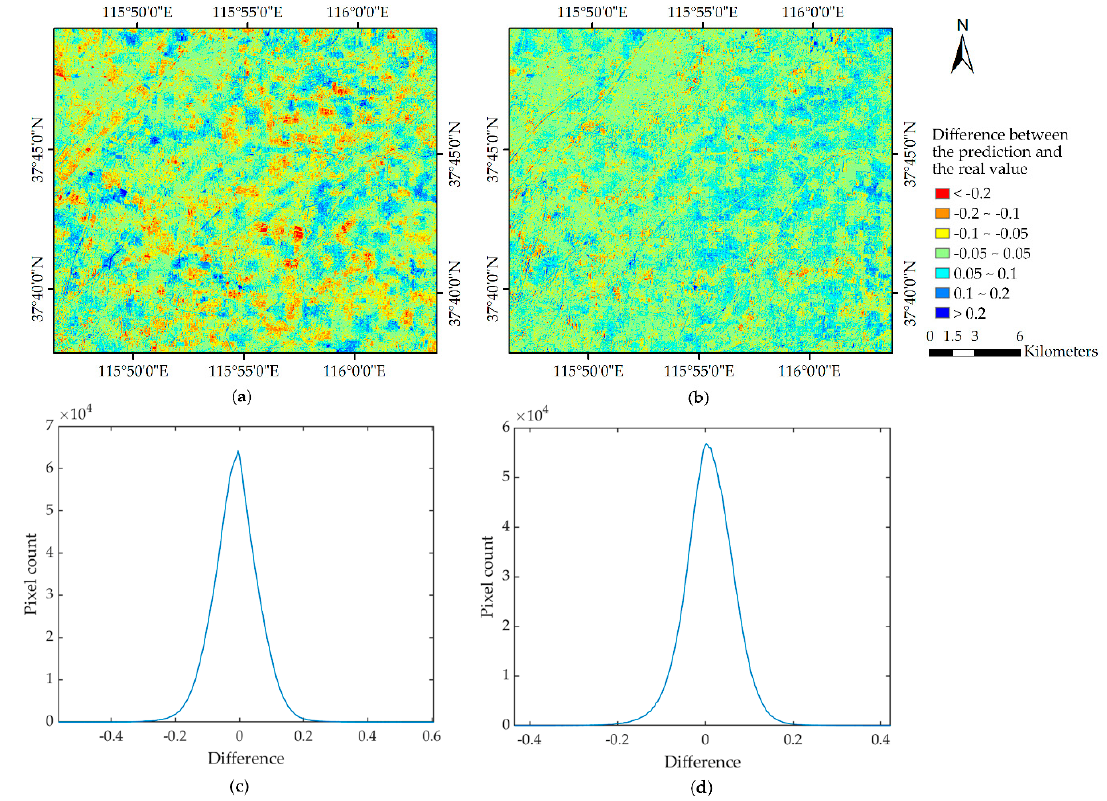
Figure 9. Difference maps of the strategy of fusing reflectance data (FC) ( a ) and the strategy of fusing derived FVC (CF) ( b ), and difference histograms of FC ( c ) and CF ( d ).